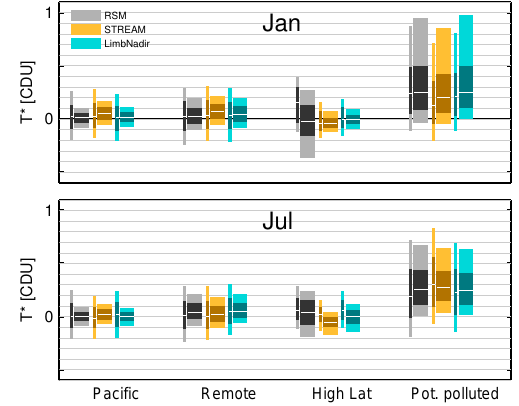
Figure 14. Regional statistics of SCIAMACHY tropospheric residues T ∗ from different algorithms for January (top) and July (bottom) 2010. Conventions as in Fig. 6.